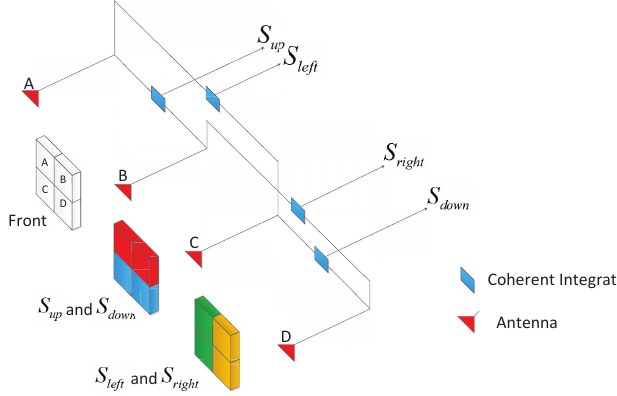
Figure 4. The coherent integration operation for angle